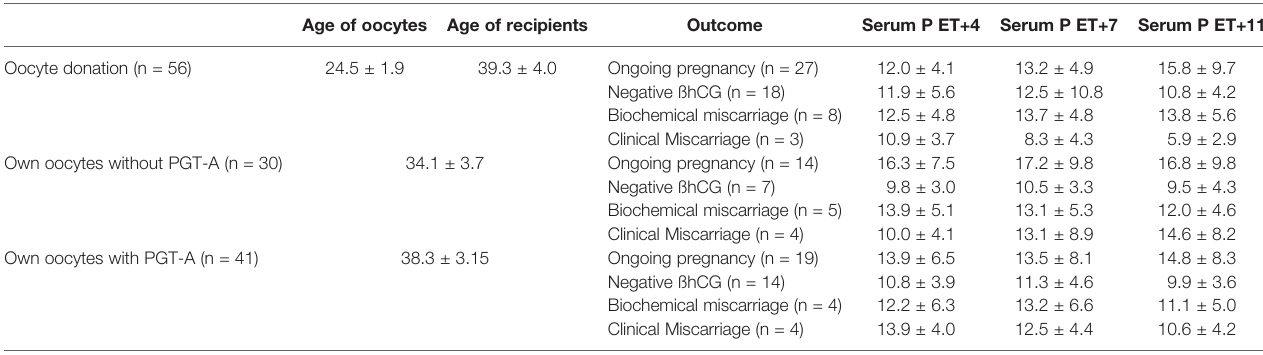
TABLE 1 | Mean serum P levels throughout the late luteal phase and outcome regarding oocytes ’ origin: oocyte donation, own oocytes without PGT-A, and own oocytes with